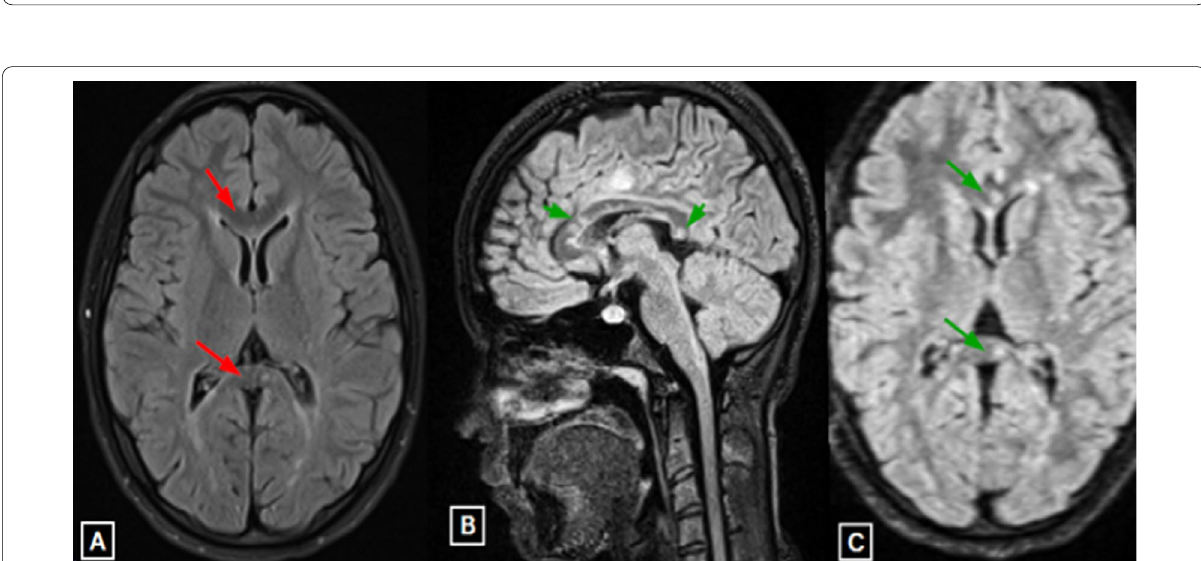
Fig. 4 Multiple callosal lesions, faintly detected at 2D FLAIR (largest indicated by red arrow in A ), is bright and well demonstrated at (green arrows at B and C ) in 3D FLAIR and axial MIP